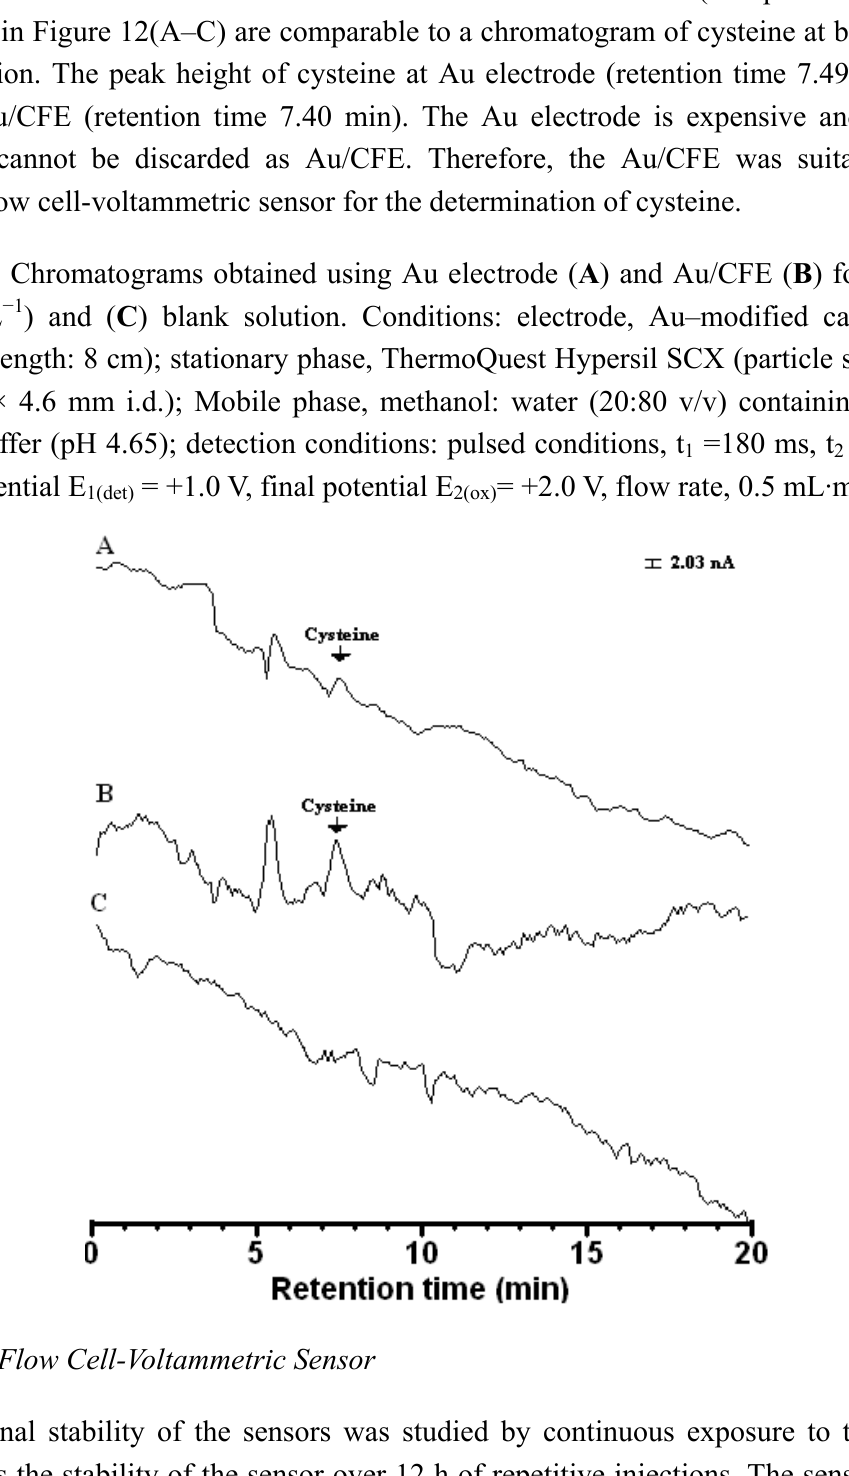
Figure 12 Chromatograms obtained using Au electrode ( A ) and Au/CFE ( B ) for cysteine (0.5 mg·L − 1 ) and ( C ) blank solution. Conditions: electrode, Au–modified carbon fiber detector (length: 8 cm); stationary phase, ThermoQuest Hypersil SCX (particle size 5 μ m , 250 mm × 4.6 mm i.d.); Mobile phase, methanol: water (20:80 v/v) containing 1.0 mM acetate buffer (pH 4.65); detection conditions: pulsed conditions, t